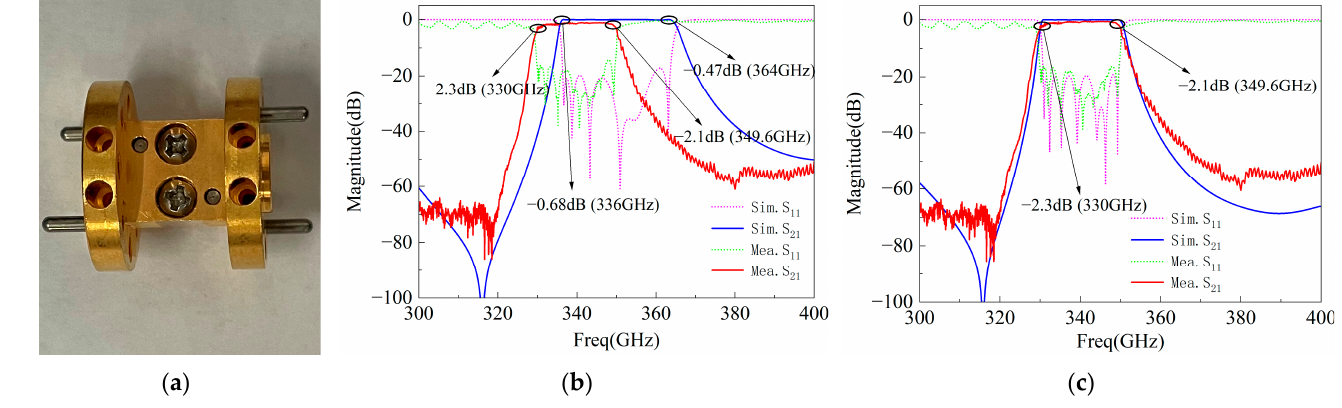
Figure 9. Third fabricated terahertz filter. ( a ) Fabricated terahertz filter based on DOC method; ( b ) comparison between measured and simulation results; ( c ) comparison between measured and desired